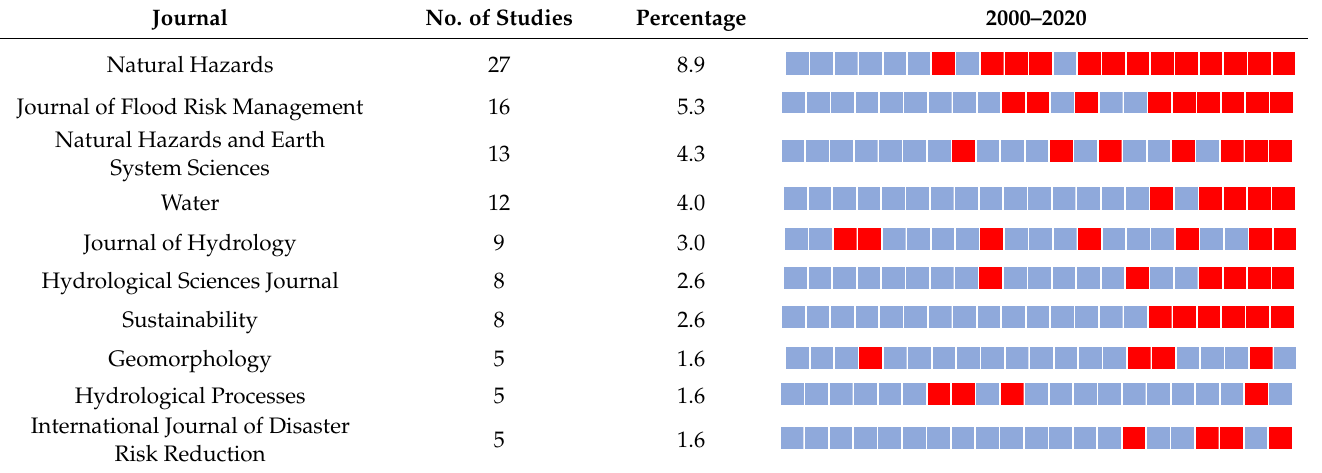
Figure 2. Annual frequency distribution of LAC flood-related articles published in WoS-registered journals.